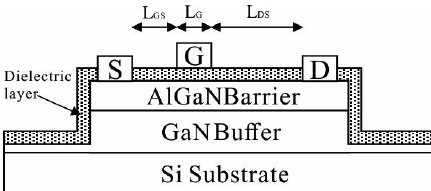
Figure 1. Metal–insulator–semiconductor high-electron-mobility transistors (MIS-HEMT) structure cross-section view.